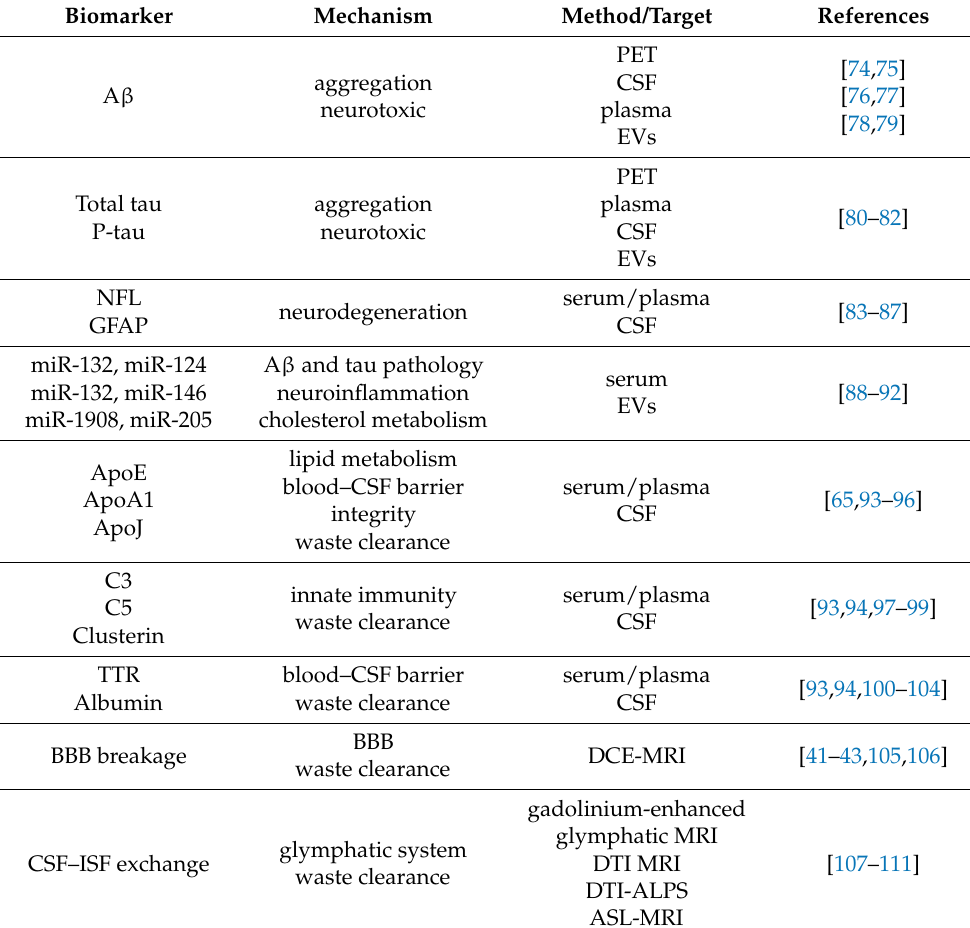
Table 1. Potential liquid-based and neuroimaging biomarkers for Alzheimer’s